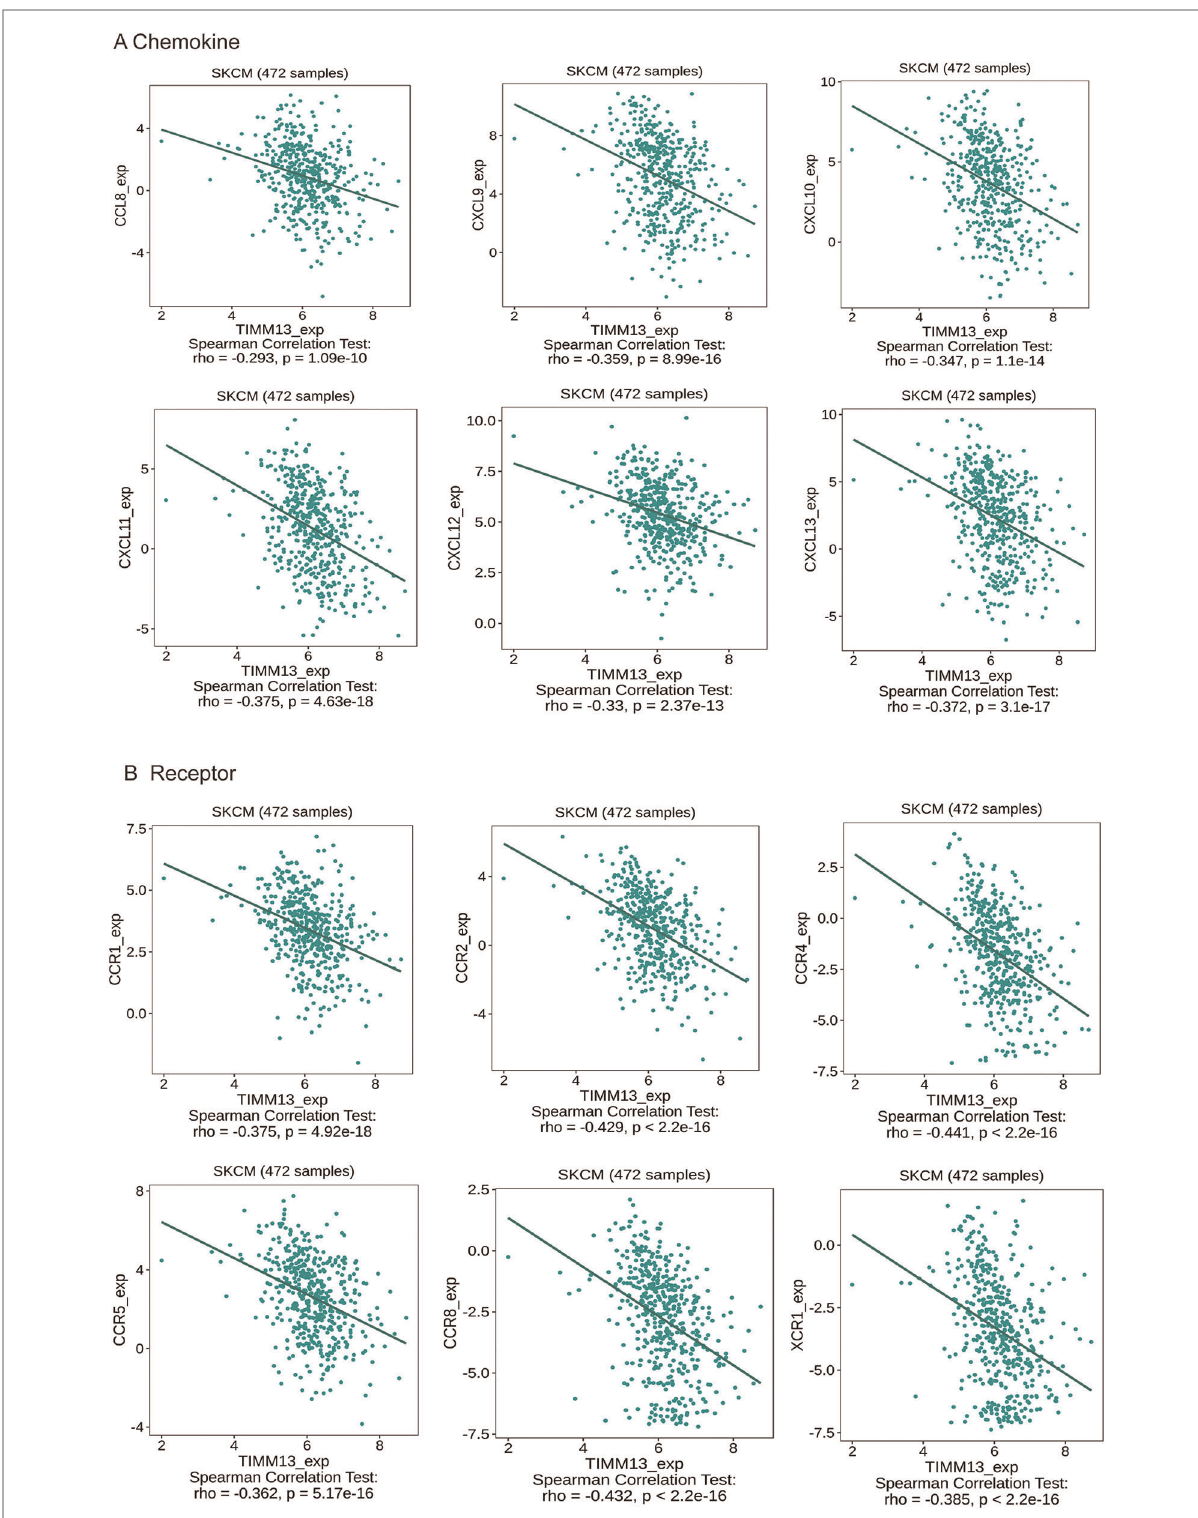
FIGURE 6 Correlation between the expression of TIMM13 and chemokines in SKCM. ( A ) Correlation between TIMM13 expression and chemokines in SKCM available at TISIDB database. ( B ) Correlation between TIMM13 expression and chemokine receptors in SKCM available at TISIDB database. Color images are available